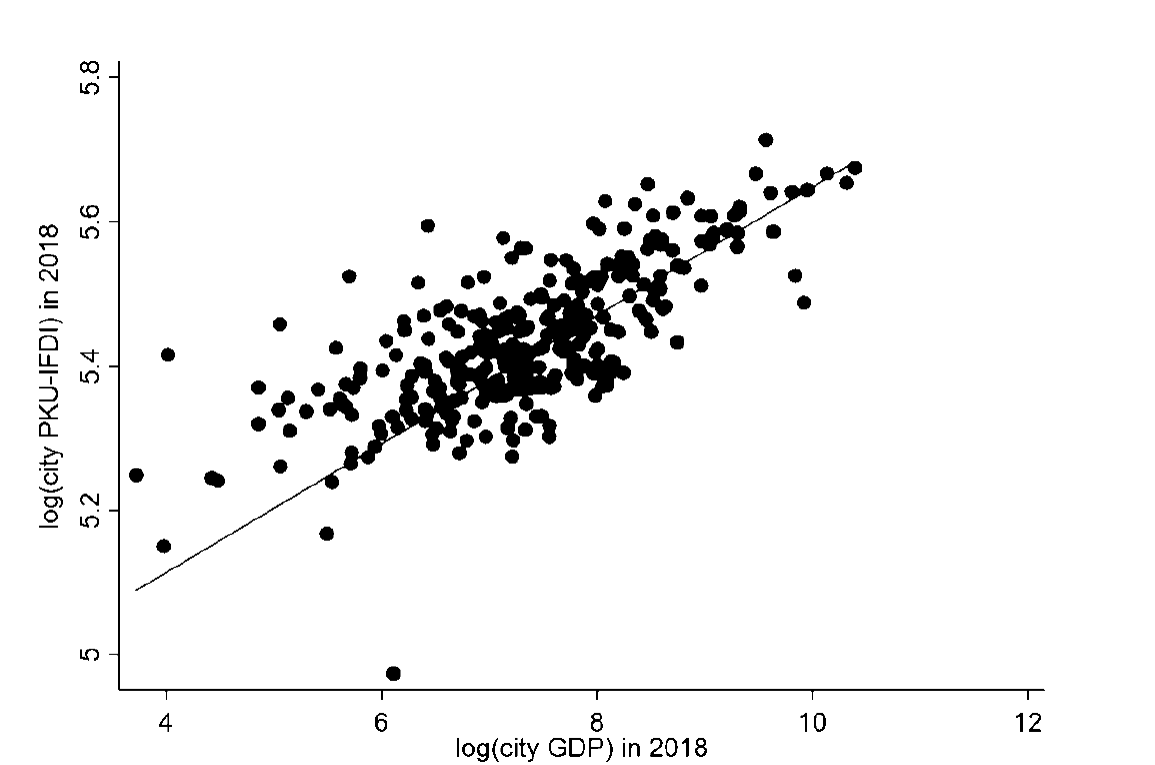
Figure 3. prefecture-level PKU-IFDI and GDP in 2018. Figure 3. Prefecture-level PKU-IFDI and GDP in